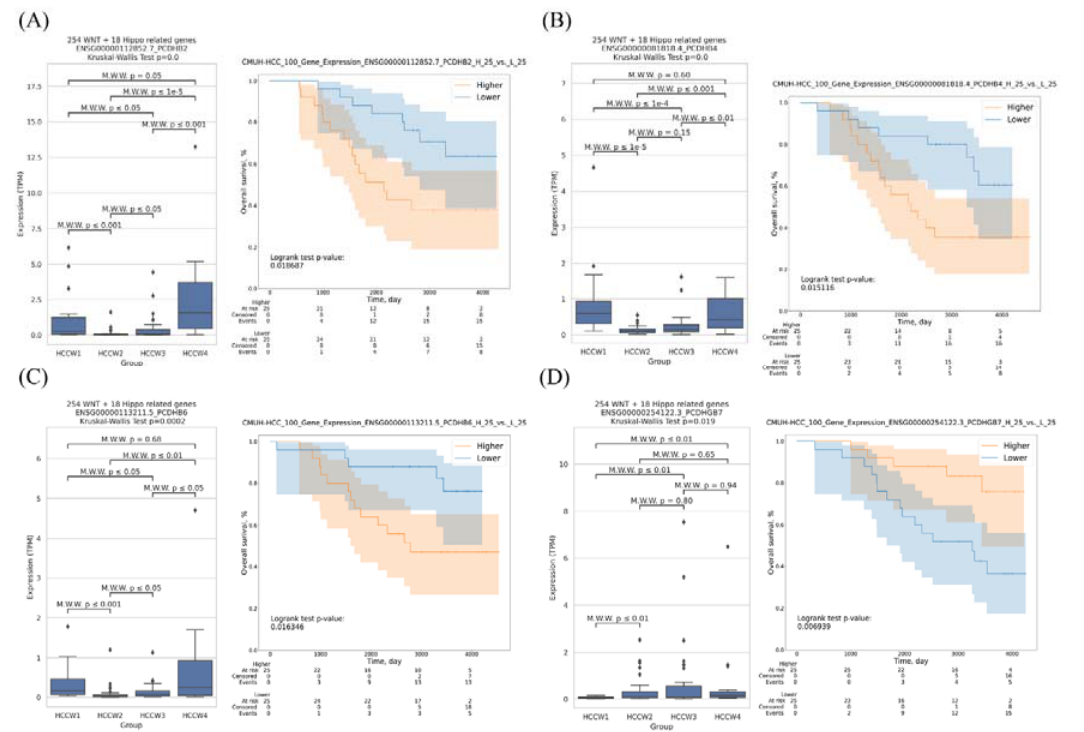
Figure 5. Correlations between molecular classifications and patient survival. Boxplot showing the expression level of ( A ) PCDHB2 , ( B ) PCDHB4 , ( C ) PCDHB6 , and ( D ) PCDHGB7 in four HCC subclasses. The statistical difference was compared through the Kruskal–Wallis test and Mann– Whitney U test, and the p -values were shown above each boxplot. Survival analysis of patients with HCC according to above-mentioned genes expression. Patients with high PCDHB2 , PCDHB4 , and PCDHB6 expression had significantly shorter overall survival compared with patients with low expression.